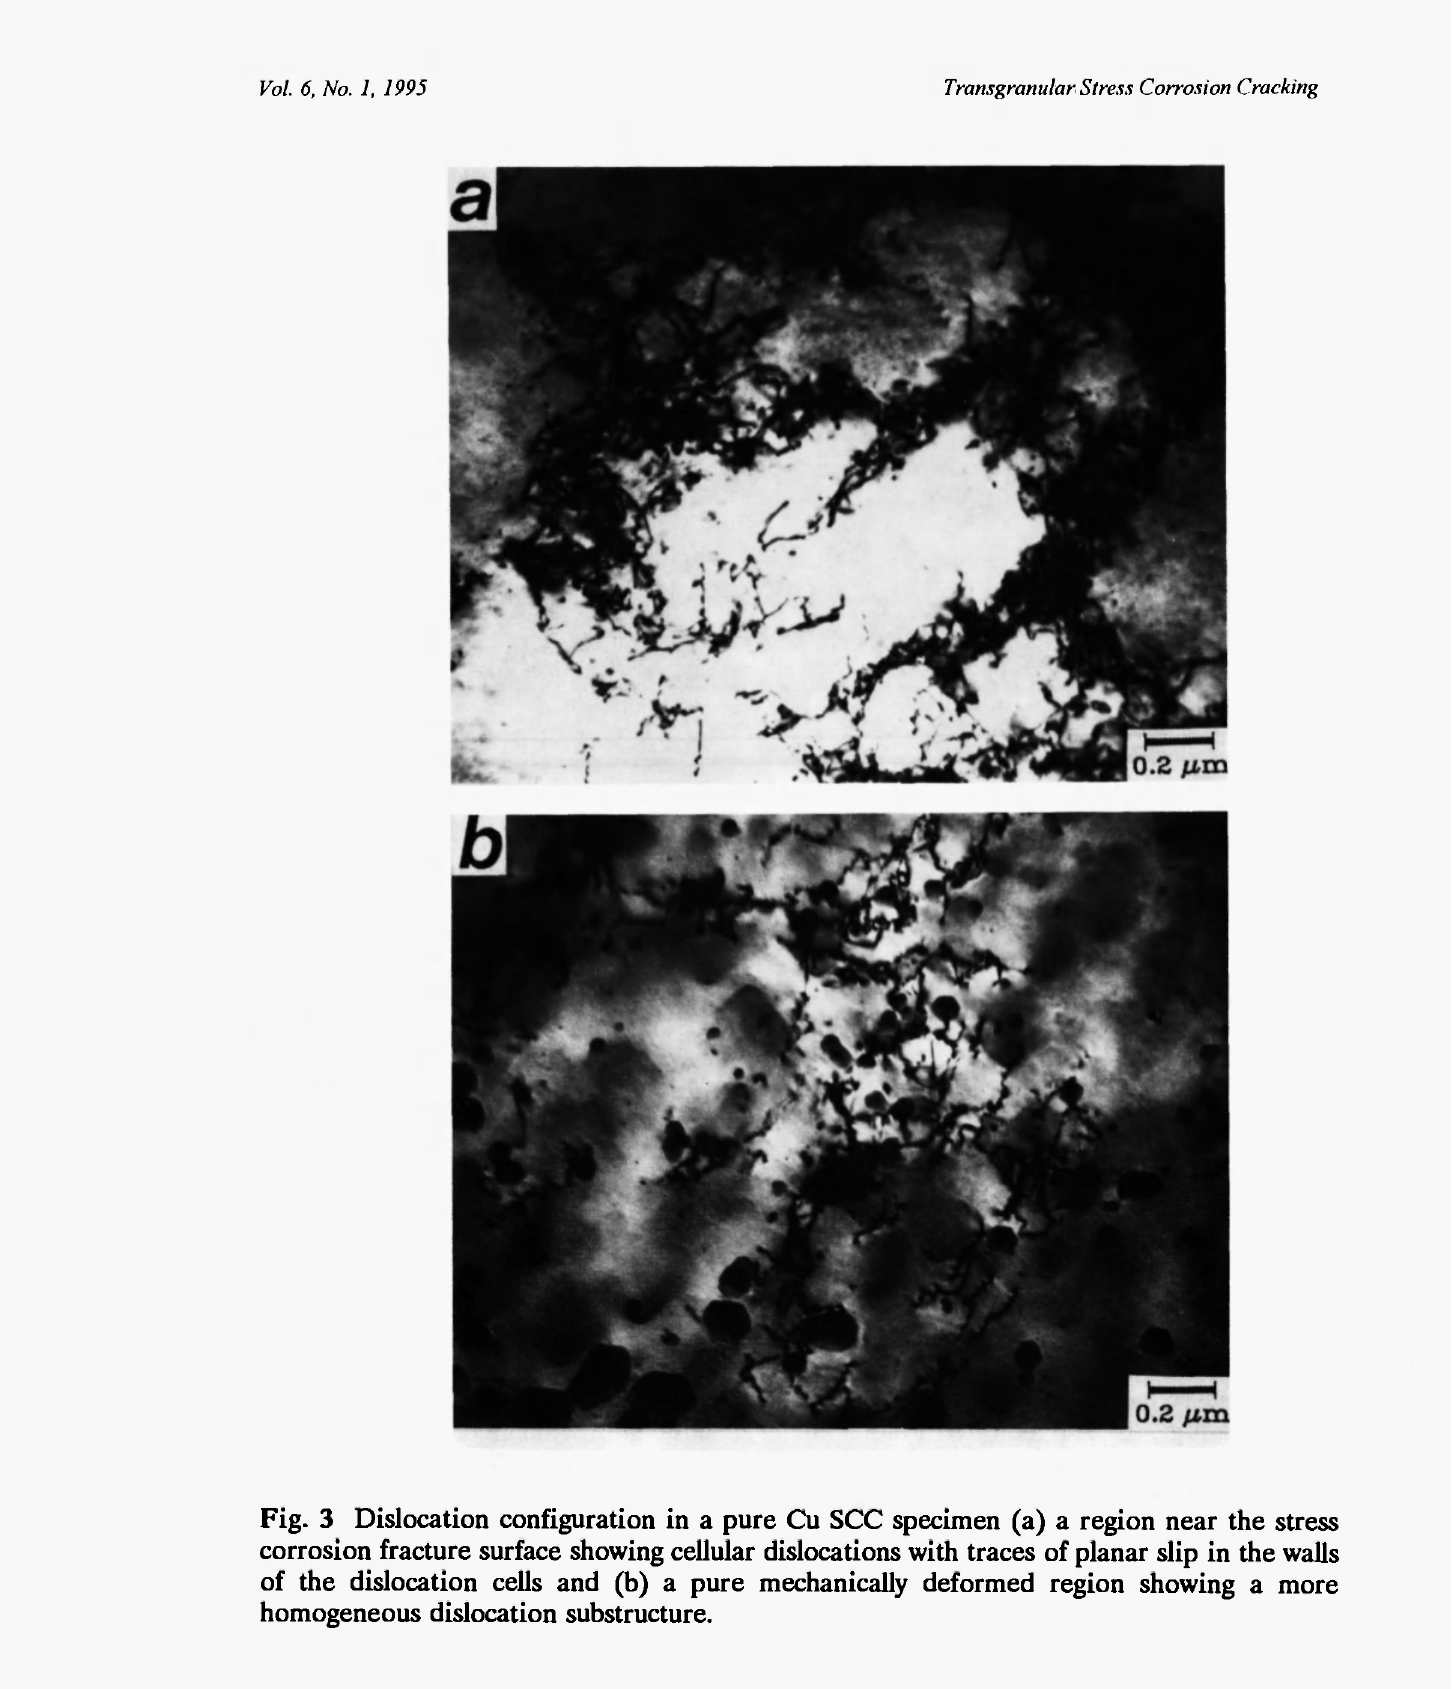
Fig. 3 Dislocation configuration in a pure Cu SCC specimen (a) a region near the stress corrosion fracture surface showing cellular dislocations with traces of planar slip in the walls of the dislocation cells and (b) a pure mechanically deformed region showing a more homogeneous dislocation